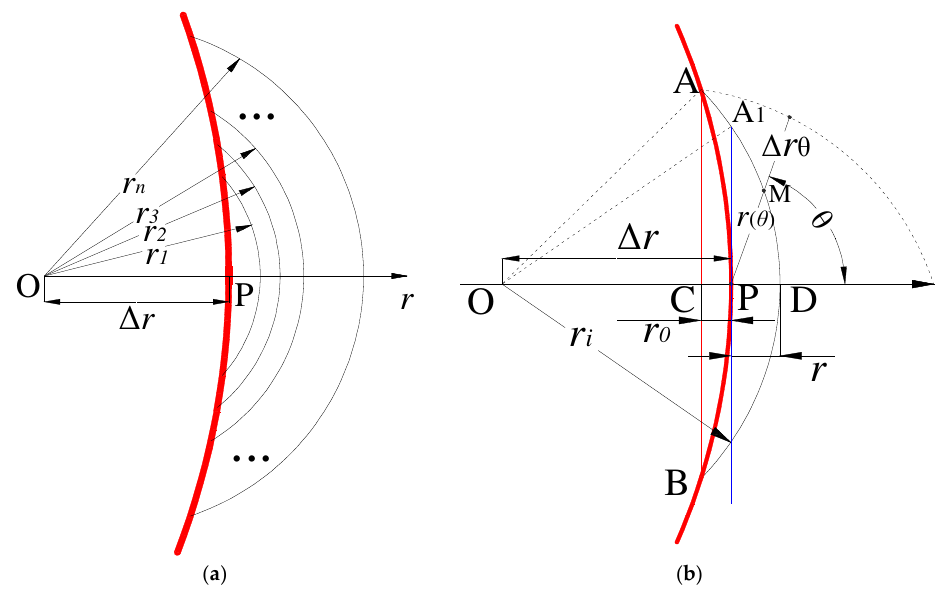
Figure 9. Schematic representation of the notched specimen with holes. ( a ) Stress contour lines at the notch root. ( b ) Relationship between stress contours and the peak point.